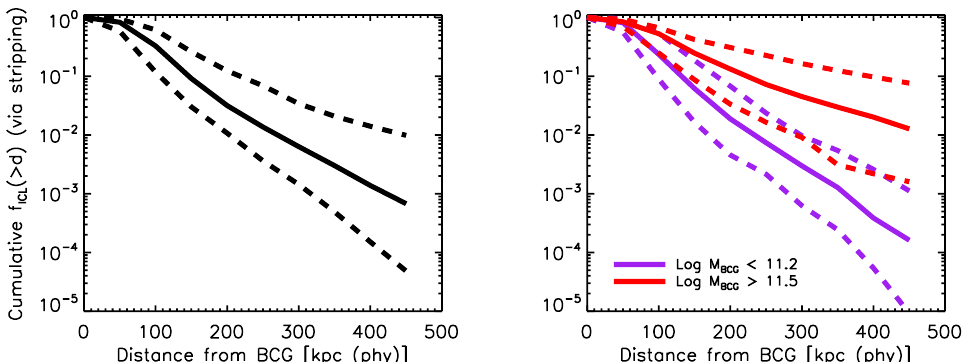
Figure 6. Left panel: cumulative fraction of stellar mass in ICL produced via stellar stripping as a function of distance from the BCG. Right panel: same as left panel, but for BCGs with log M ∗ [ M (cid:12) ] < 11.2 (purple lines) and BCGs with log M ∗ [ M (cid:12) ] > 11.5 (red lines). In both panels, solid and dashed lines represent the median, the 16th and 84th percentiles of the distributions, respectively. Credit: Contini et al. [6].